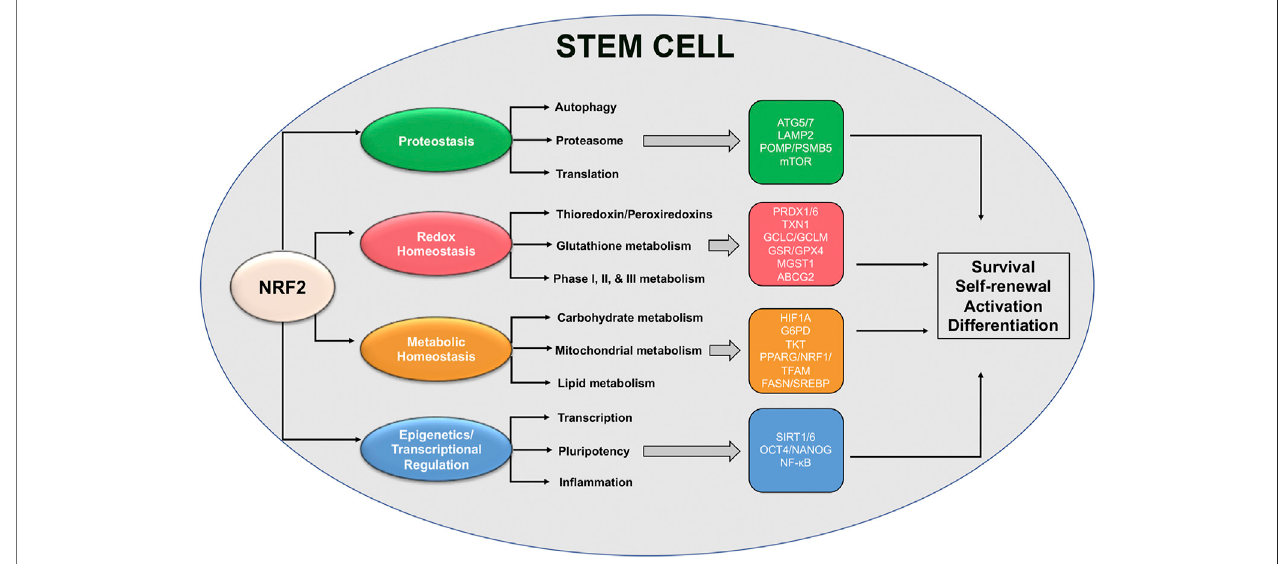
FIGURE 3 | Proposed NRF2-based redox and metabolic pathways governing stem cell function. Schematic representation of NRF2-regulated pathways and speci fi c downstream transcriptional targets that have been shown to play a role in mediating stem cell survival, self-renewal, and activation/differentiation.